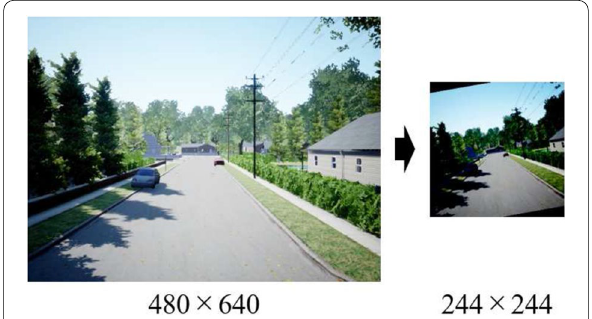
Fig. 4 Example of a transformed image. An image is randomly rotated according to �φ . This example shows an image when �φ = 10 deg . It is also resized, and is